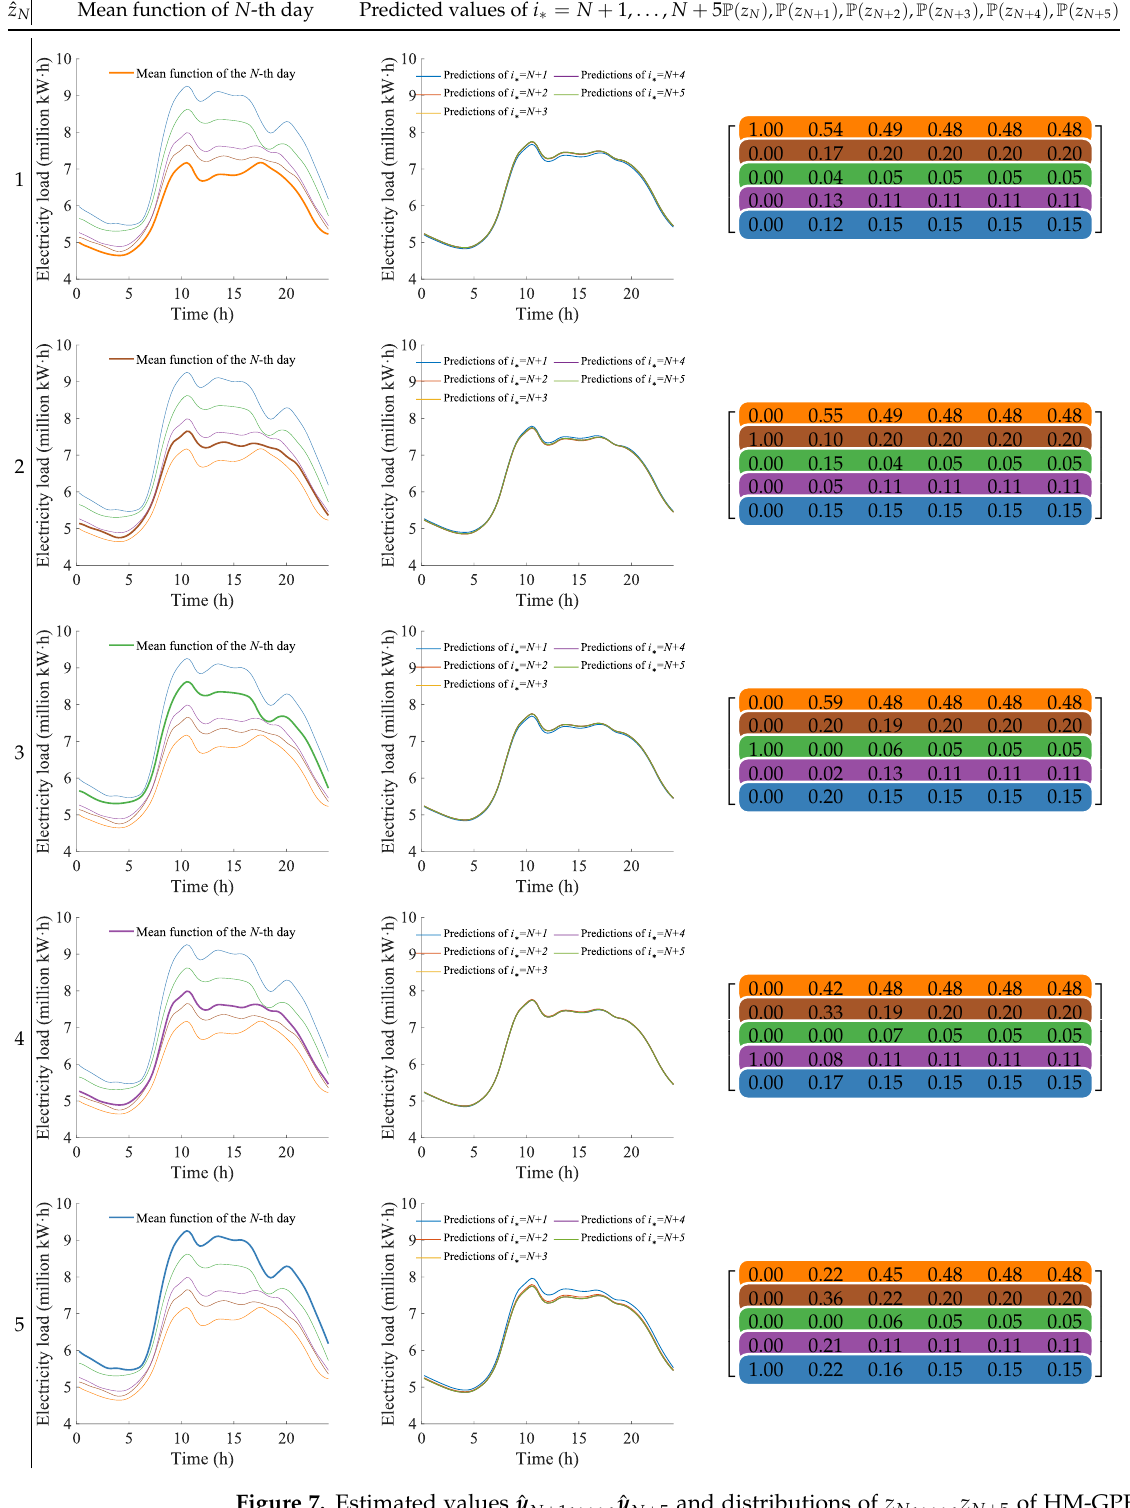
, . . . , ˆ y and distributions of z N , . . . , z N + 5 of HM-GPFR under N + 1 N + 5